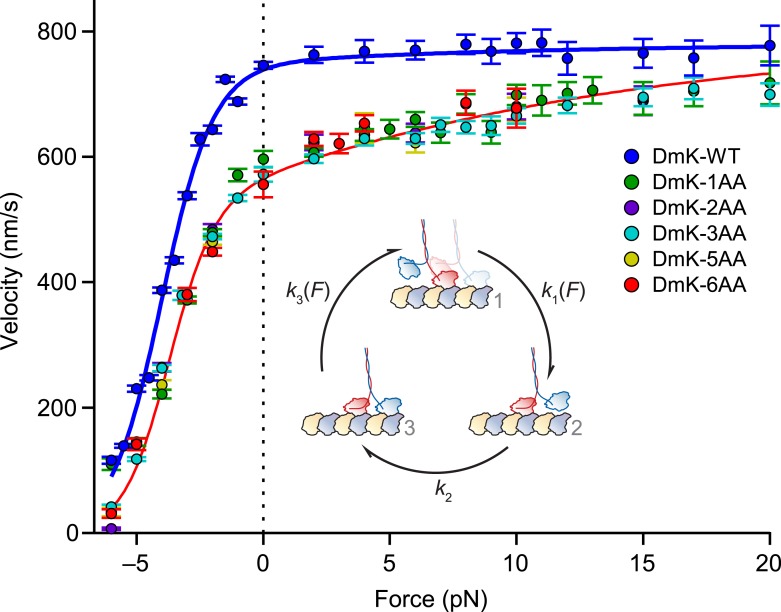
Assisting load can rescue the velocity of mutants with extended NLs.Velocity (mean ± SE; N = 49‒818) as a function of force for constructs (solid circles; color-coded according to the legend). Data were collected under the same conditions as Figure 3. DmK-WT velocity was not affected by assisting loads, but the velocities of all mutant constructs could be increased by larger assisting loads. Solid lines show the global fit to a minimal 3-state model (inset) for WT (blue) and mutant (red) constructs, with parameters in Table 2. Data sets for both DmK-WT and DmK-3AA under hindering loads are from (Andreasson et al., 2015). Force–velocity data are compared to other mutant constructs in Figure 7.